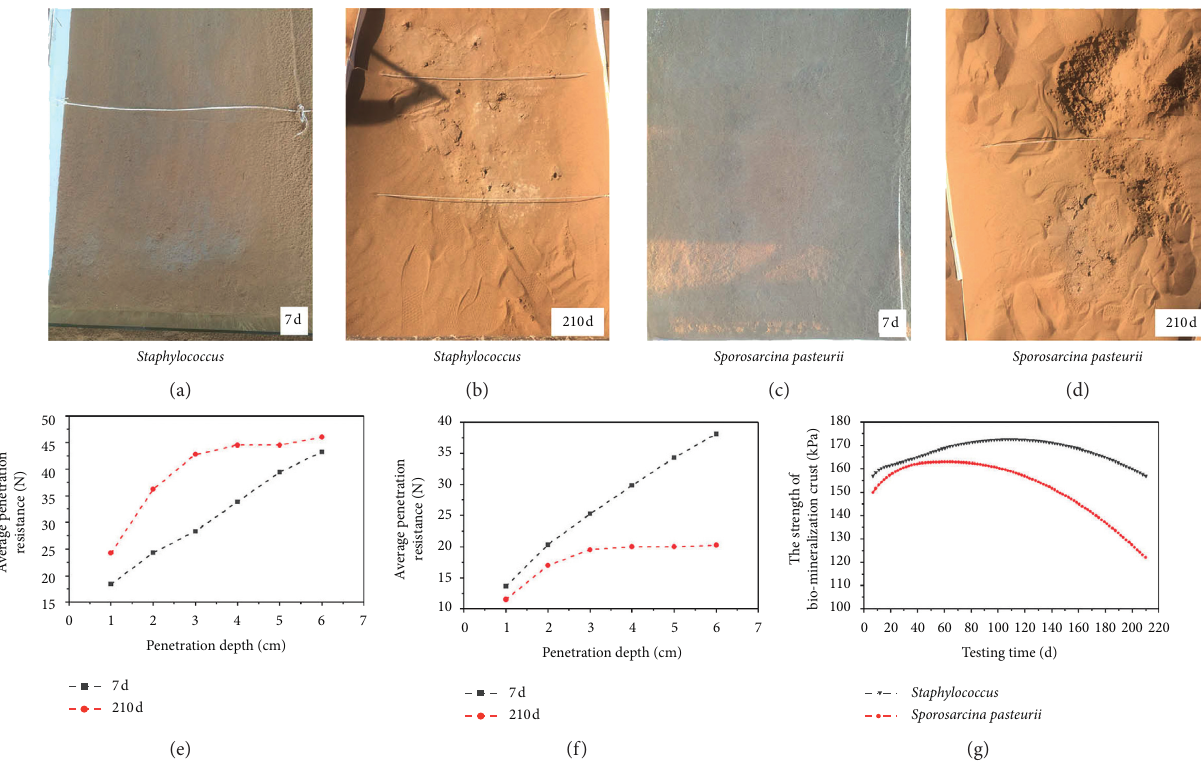
Figure 11: Field penetration test; (a) the crust effect (7d ∼ Staphylococcus ); (b) The crust effect (210d ∼ Staphylococcus ); (c) the crust effect (210d ∼ Sporosarcina pasteurii ); (d) the crust effect (210d ∼ Sporosarcina pasteurii ); (e) the penetration resistance changing ( Staphylococcus ); (f) the penetration resistance changing ( Sporosarcina pasteurii ); (g) the strength of biomineralization crust fo r Staphylococcus and Sporosarcina pasteurii